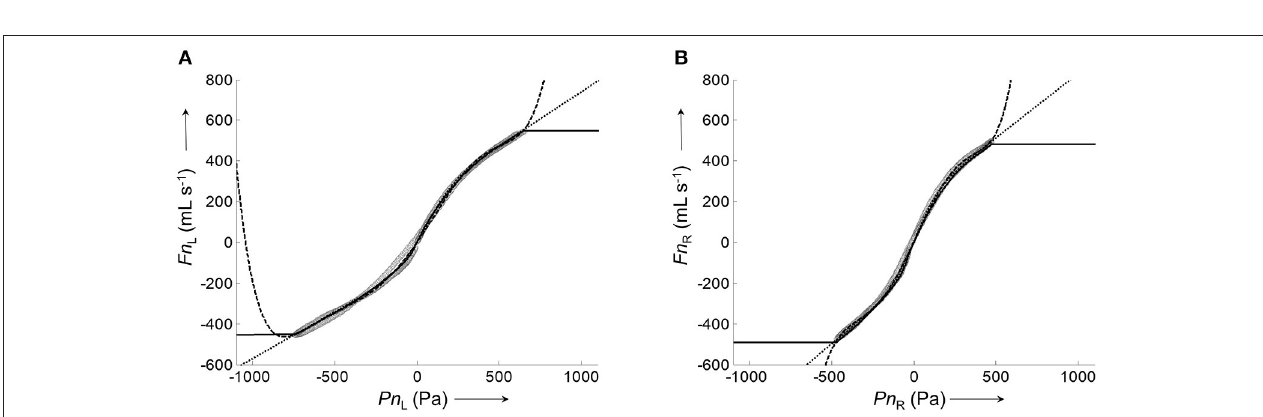
FIGURE 4 | Representative calibration curves for the left and right nasal side fitted by different algorithms to the corresponding pairs of average airflow and pressure signals. (A) , Plot of the average left nasal airflow (data shown in Figure 3F ) against the average left nasal pressure (data shown in Figure 3E ). (B) , Plot of average right nasal airflow (data shown in Figure 3F’ ) against the average right nasal pressure (data shown in Figure 3E’ ). Calibration curves were fitted to the data (gray circles) by different algorithms: lowess smoother (solid), polynomial fit (dashed), and 8-PL function (dotted).